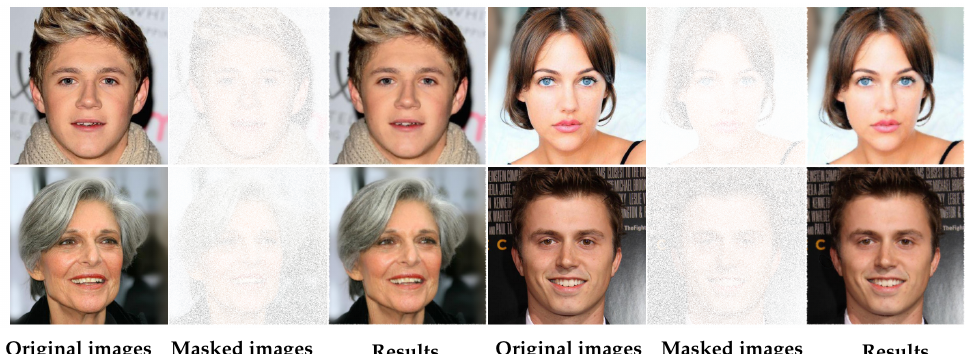
Figure 12. Inpainting results for 90% random noise masked face images.